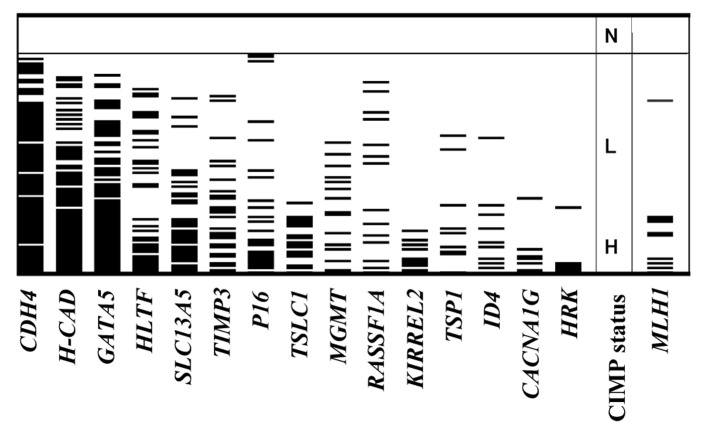
Summary of methylation of 15 promoter CpG islands in 104 colorectal cancers. Gray bars indicate methylation of each gene. CpG island methylator phenotype (CIMP) status and MutL homolog 1 (MLH1) methylation shown by gray bars are specified on the right of the methylation data map.